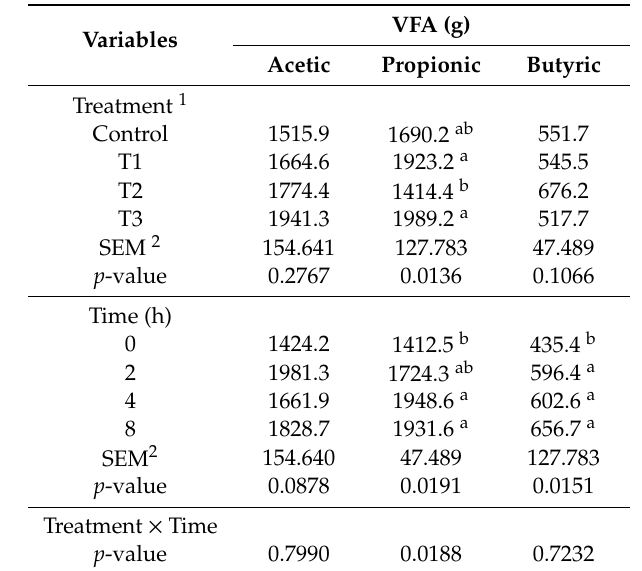
Table 2. E ff ect of treatments and time volatile fatty acids (VFA) in rumen fluid of the growing Naemi